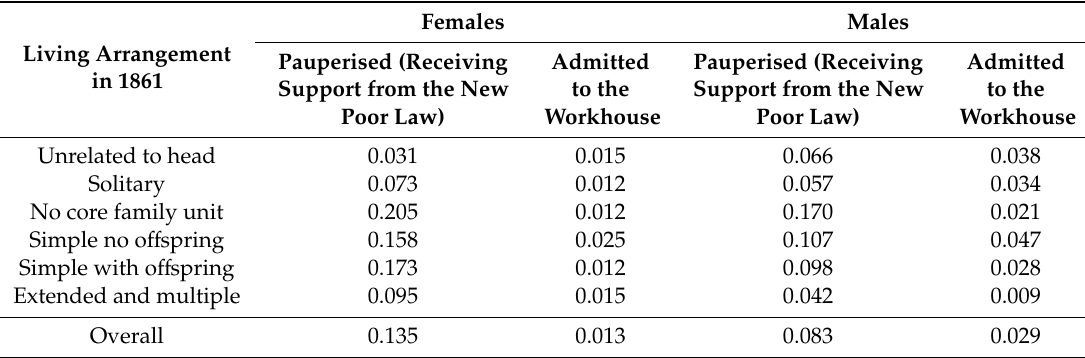
workhouse when aged over 60 years in the early